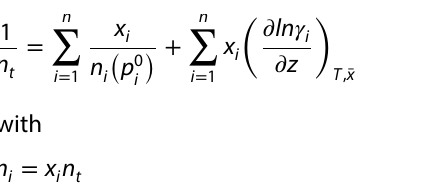
Fig. 15 Binary adsorption equilibria of CO Ni-MOF-74 at T = 303.15 K and p = 5 bar